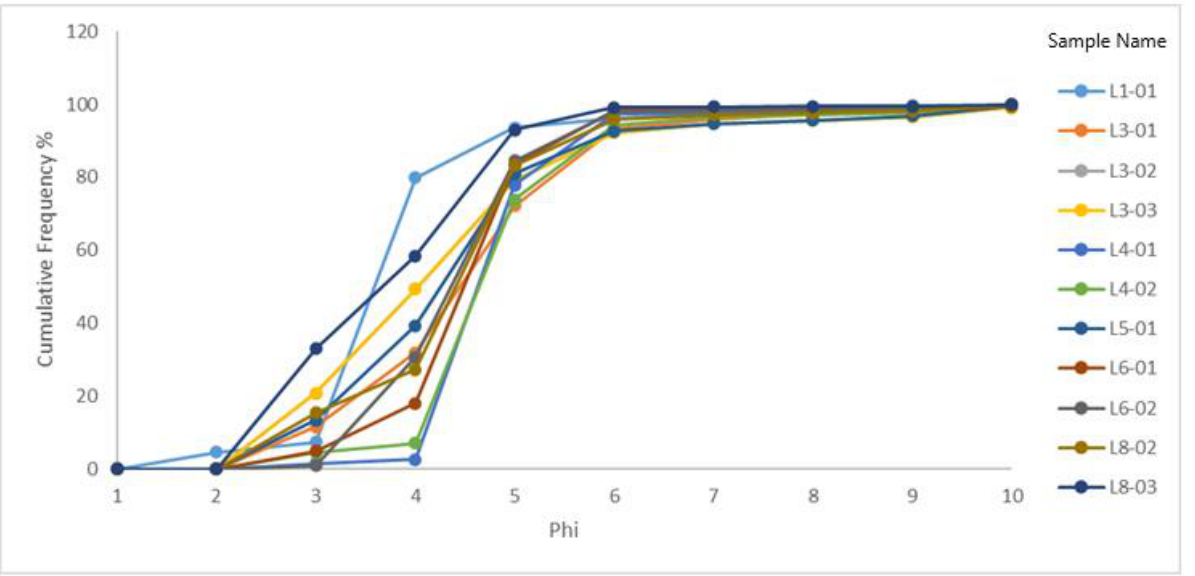
Figure 22. Grain size cumulative frequency curves showing the range of grain size distribution of the studied samples.